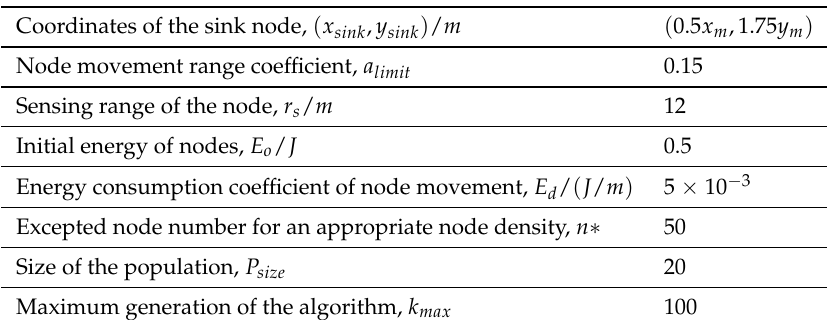
Table 1. Parameter